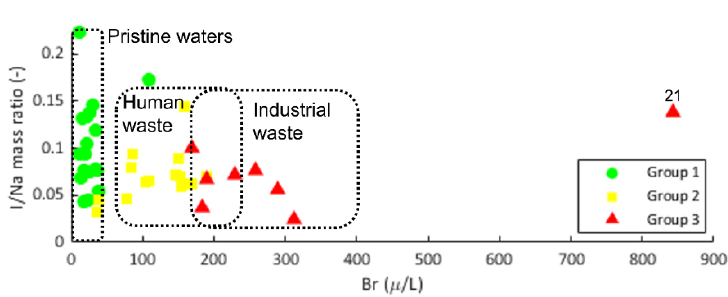
Figure 8. Plot showing the relationship between the I/Na mass ratio and Br. For all groundwater samples taken on November 2020, strong positive correlations were observed between Br − and NO 3 -N and ACE ( r = 0.85 and r = 0.81, respectively; p < 0.001) and SUC ( r = 0.77 and r = 0.71, respectively; p < 0.001) (Figure 6). This suggests that